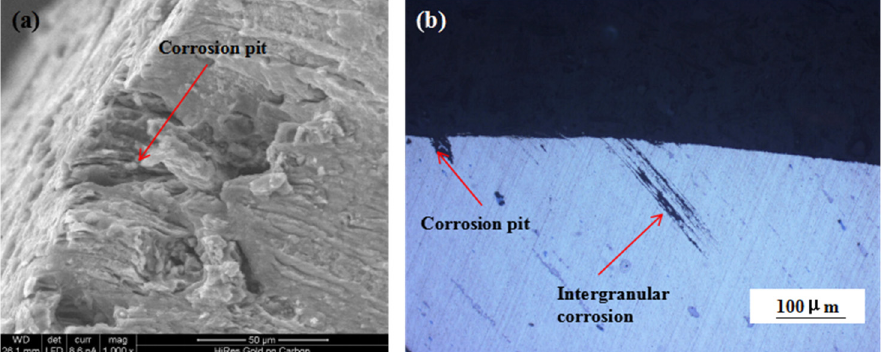
Figure 10. Fracture ( a ) and cross-sectional ( b ) morphologies of the 7075 alloy tensile specimen after exposure to the marine atmospheric environment.